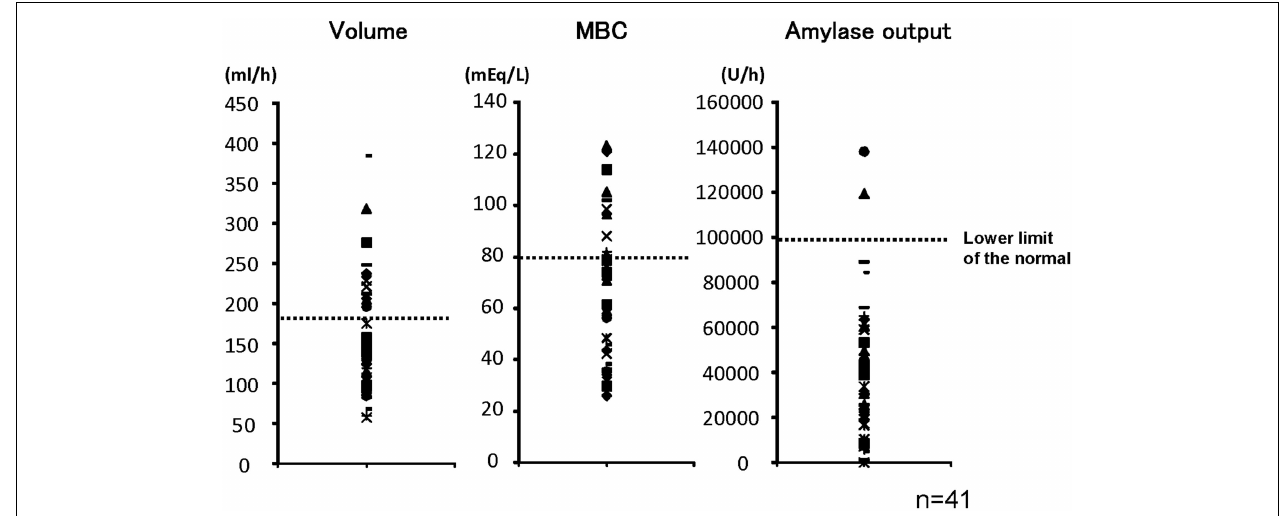
) concentration in pancreatic juice (MBC: lower maximum bicarbonate (HCO − 3 limit of normal, 80mEq/l), and total amylase output (AO: lower limit of normal, 99,000U/h), were all impaired in most of the patients with chronic pancreatitis (Ko et al.,